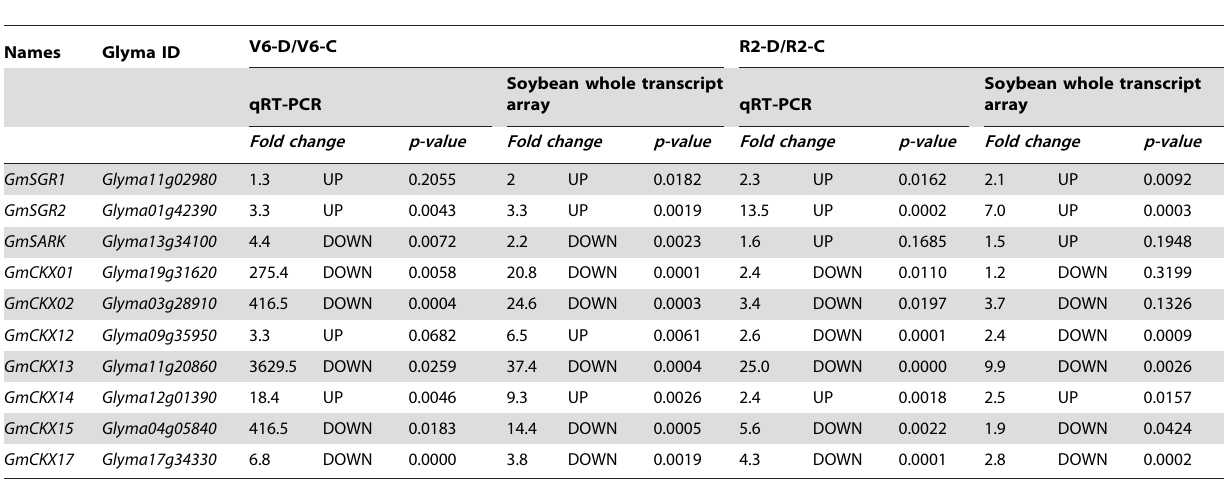
Table 1. Confirmation of microarray data by qRT-PCR